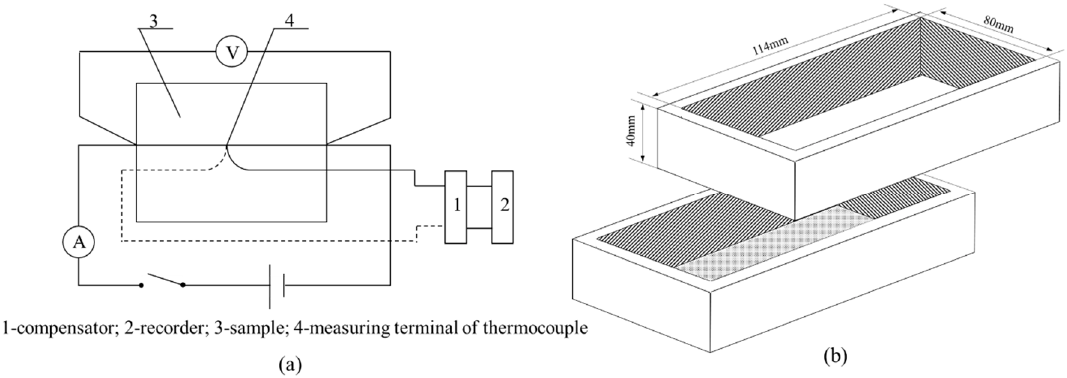
Figure 1. ( a ) Schematic diagram of measuring circuit and ( b ) sample boxes